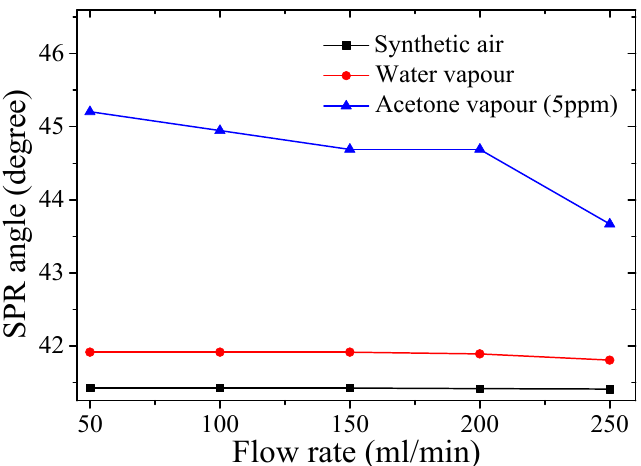
Figure 5. SPR angle vs. flow rate on the response of chitosan-PEG-based SPR sensor in synthetic air (carrier gas), water vapor, and 5 ppm acetone vapor.